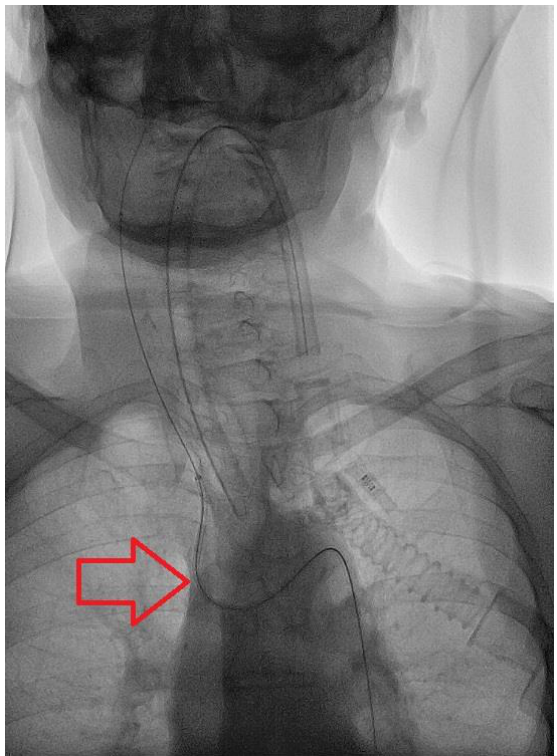
Figure 2. Findings: Antero-posterior view during catheterization of the anonymous trunk shows type-3 Aortic Arch.Technique: Pulsed Fluoroscopy; 15 pulses per second.